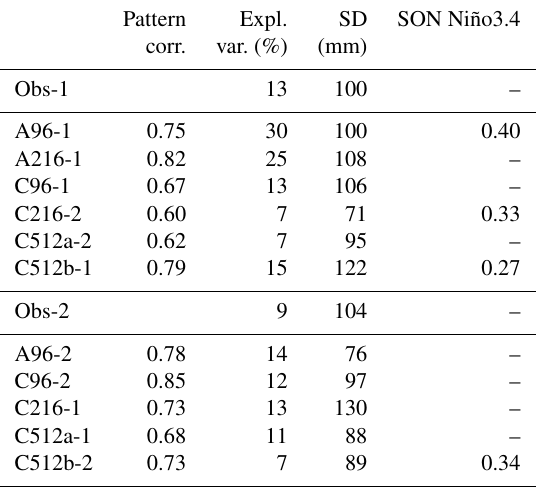
Table 4. Performance statistics of simulated EOTs compared to ob- servations for SON. Column (1) observed (Obs) and simulated (la- belled by simulation name) EOT patterns; numbers indicate the or- der of the EOT pattern. (2) Linear pattern correlation coefficient of simulated and observed precipitation anomalies; (3) explained space–time variance of the EOT pattern; (4) standard deviation of the EOT time series; (5) Spearman’s rank correlation of the EOT time series with the SON Niño3.4 that are significant at the 95% confidence